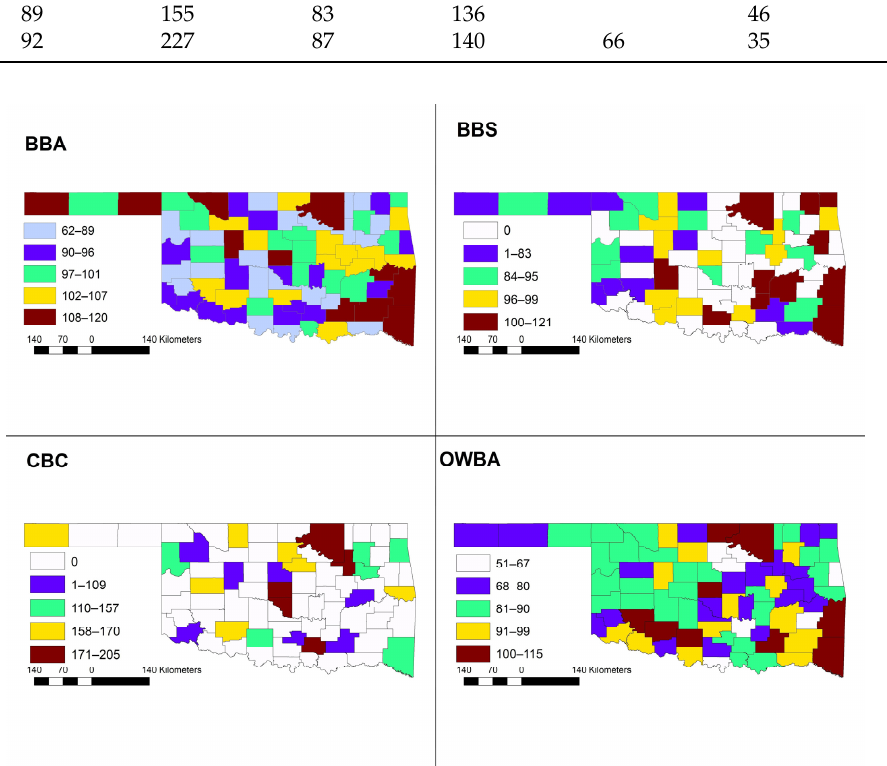
Figure 2. Species richness of species identified arranged by quantiles, a statistical method to divide observations in a sample into approximately equal numbers of observations per group, for Breeding Bird Atlas (OBBA), Breeding Bird Sur- vey (BBS), Christmas Bird Counts (CBC) and Winter Bird Atlas (OWBA).